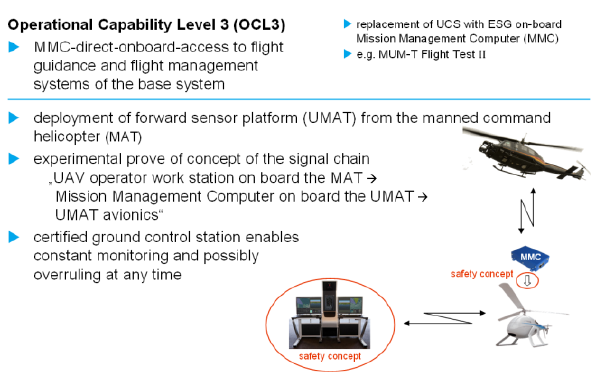
Fig. 9 Depiction of UMAT Operational Capability Level